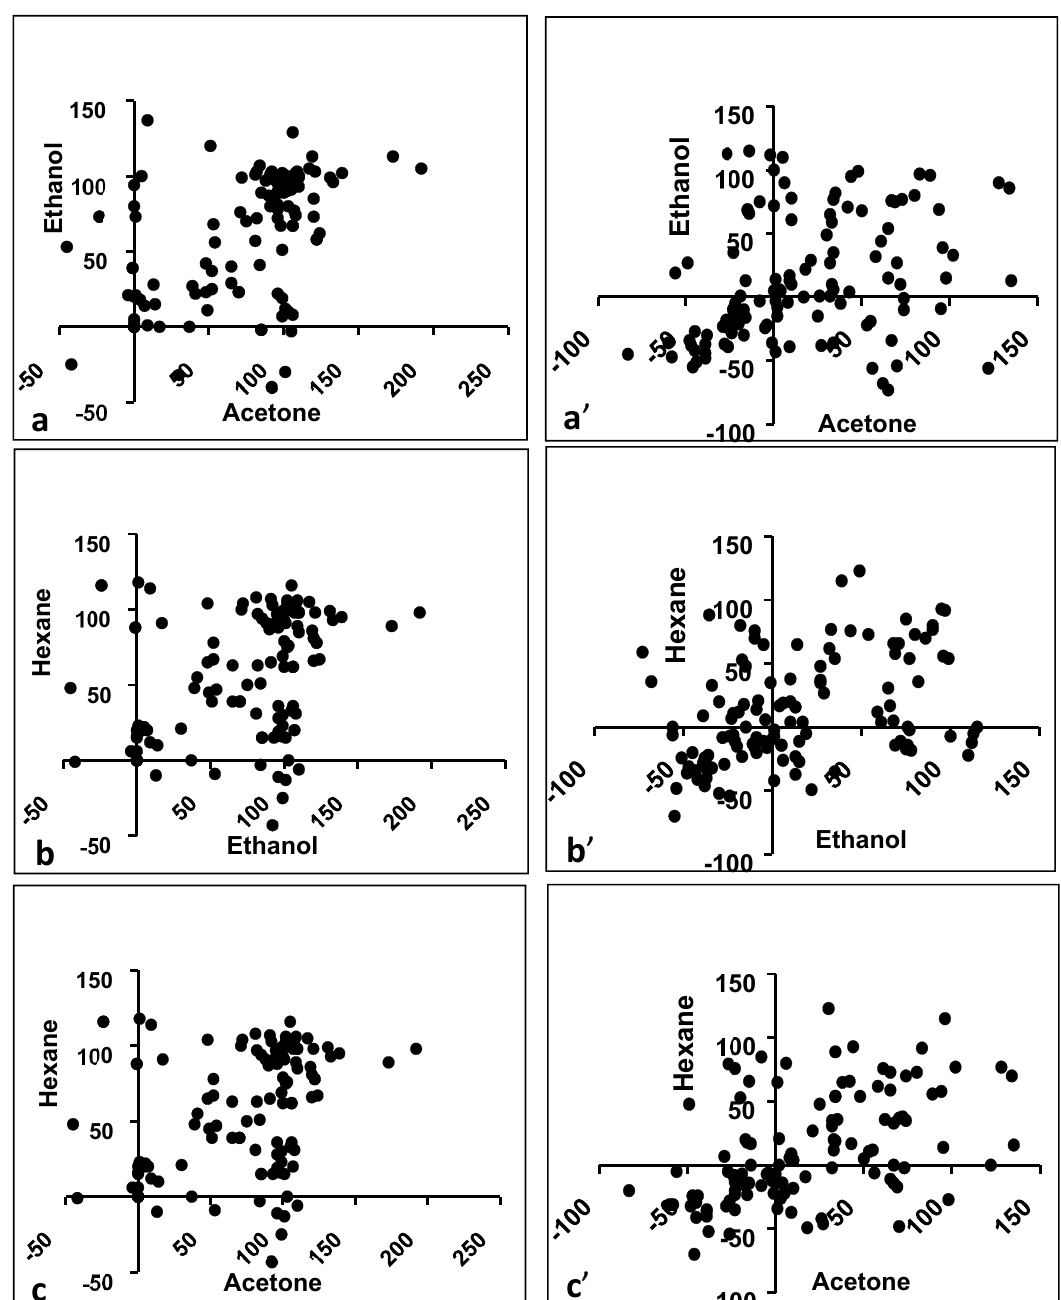
Figure 2. Antimicrobial activity correlation between extracts in di ff erent solvents for Gram-positive and Gram-negative bacteria. ( a ) Acetone vs. Ethanol (Gram-positive), ( a ’) Acetone vs. Ethanol (Gram-negative), ( b ) Ethanol vs. Hexane (Gram-positive), ( b ’) Ethanol vs. Hexane (Gram-negative), ( c ) Hexane vs. Acetone (Gram-positive), ( c ’) Hexane vs. Acetone (Gram-negative).